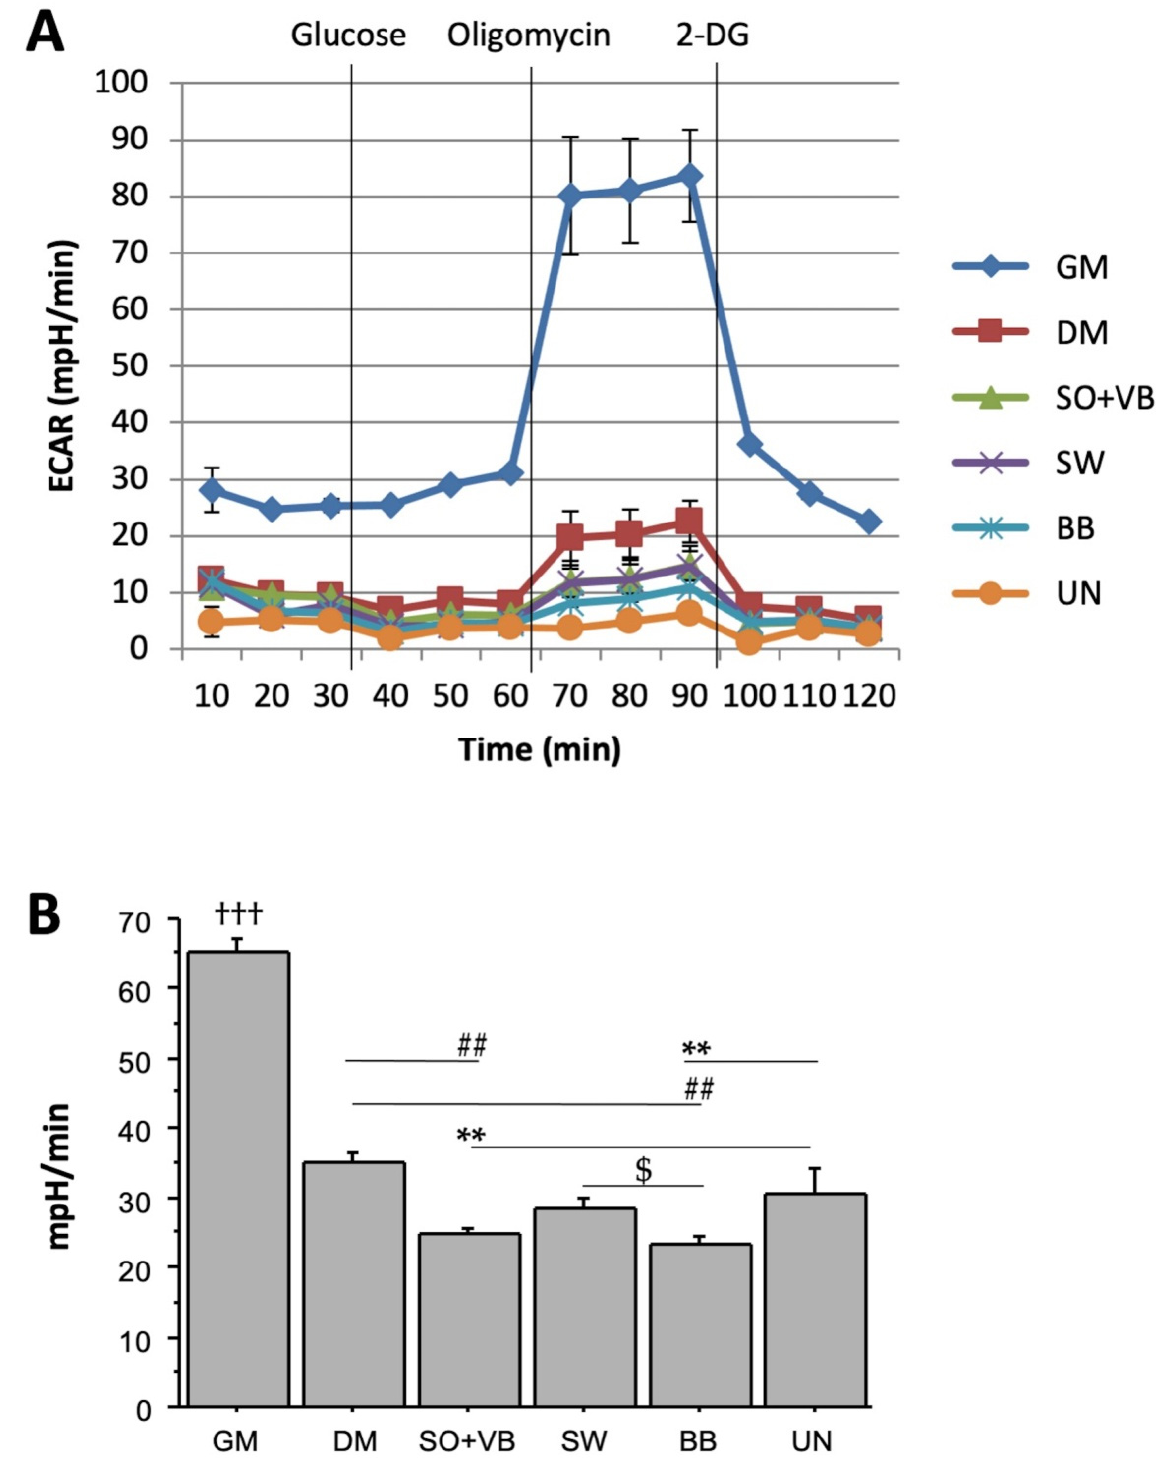
Figure 1. Extracellular acidification rate (ECAR) measured in real time under basal condition and in response to glucose, oligomycin and 2-deoxy-D-glucose (2DG) in differently trained sera-treated LHCN-M2 cells. ( A ) Bioenergetic profiling of differently treated LHCN-M2 cells. ( B ) Glycolytic capacity measured after the addition of oligomycin. Data expressed as mean ± SEM of four independent experiments. Data comparison between groups were performed using the Student’s t -test. ††† p < 0.001 GM vs. all treated cells; ** p < 0.01 vs. UN; ## p < 0.01 vs. DM; $ p < 0.01 SW vs. BB.